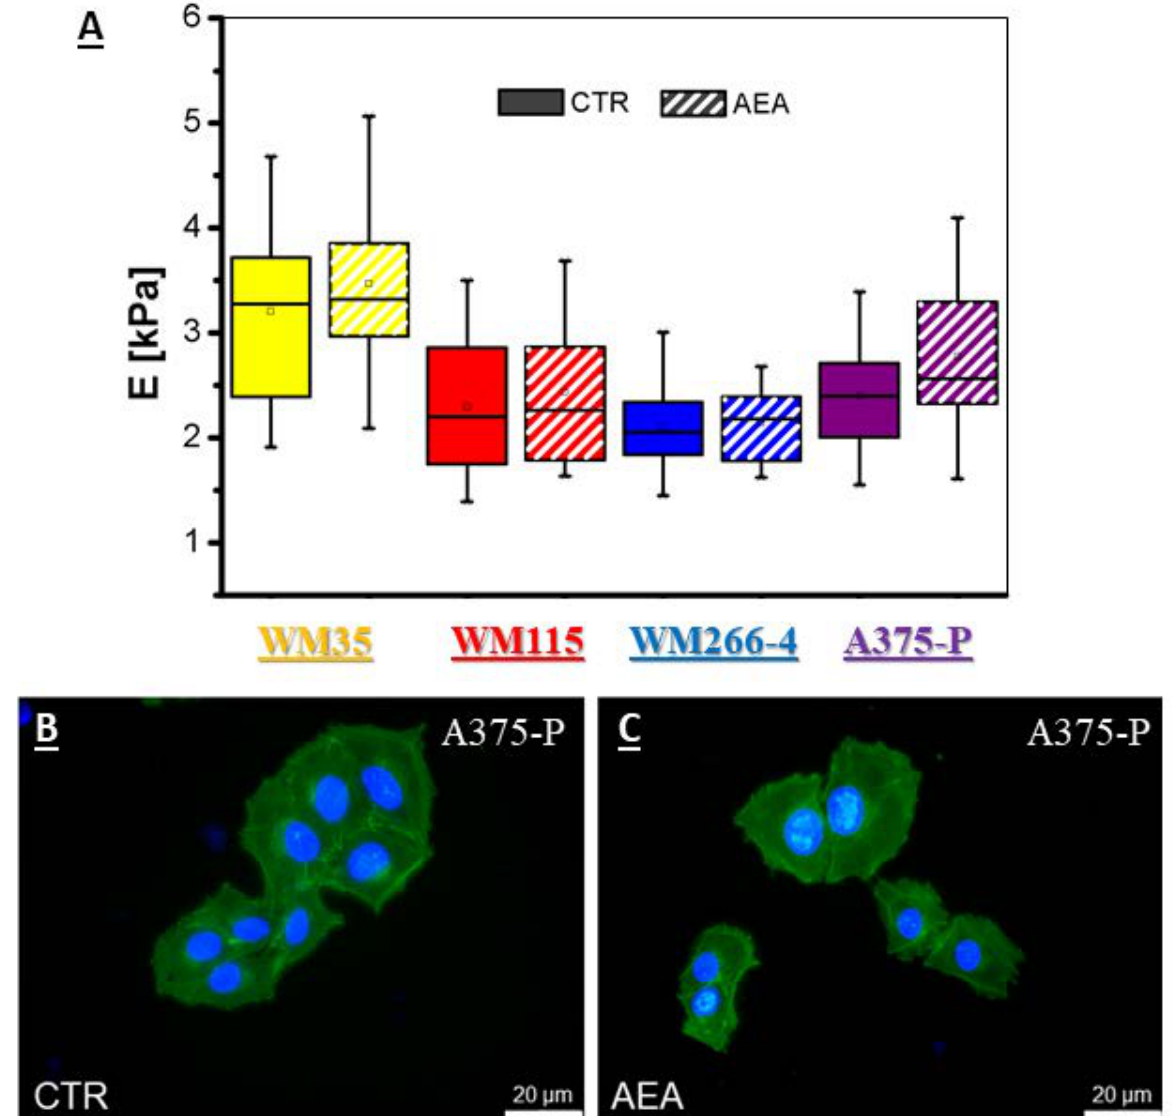
Figure 9. ( A )—the calculated elastic modulus of different melanoma cell lines treated with 1 µ M AEA at the indentation depth of 300 nm. Cell lines: WM35—primary RGP site; WM115—primary VGP site; WM266-4—metastasis to the lymph node; A375-P—solid tumor metastatic site. The representative pictures of A375-P melanoma cells: control ( B ) and treated with 1 µ M AEA ( C ) after cell staining with phalloidin labeled with Alexa Fluor 488 (ex. 495 nm, em. 518 nm) and Hoechst 33342 (ex. 350 nm, em. 461